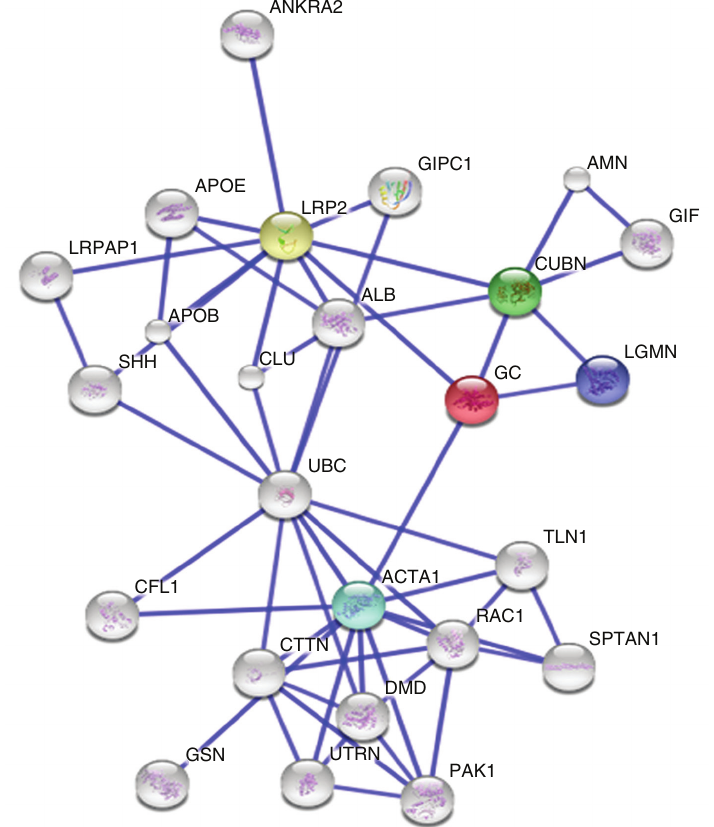
Figure 3. The associations of Vitamin D binding protein (‘GC’ in the figure) were explored using the STRING v10 clustering tool. The colored nodes signify a direct interaction with DBP whereas the white nodes denote a distant interaction. 4 proteins, LRP2 (yellow node), Cubilin (CUBN, green node), alpha 1 actin (ACTA1, blue node) and legumain (LGMN, violet node) are directly interacting with DBP and LRP2 is being shown the highest interacting score